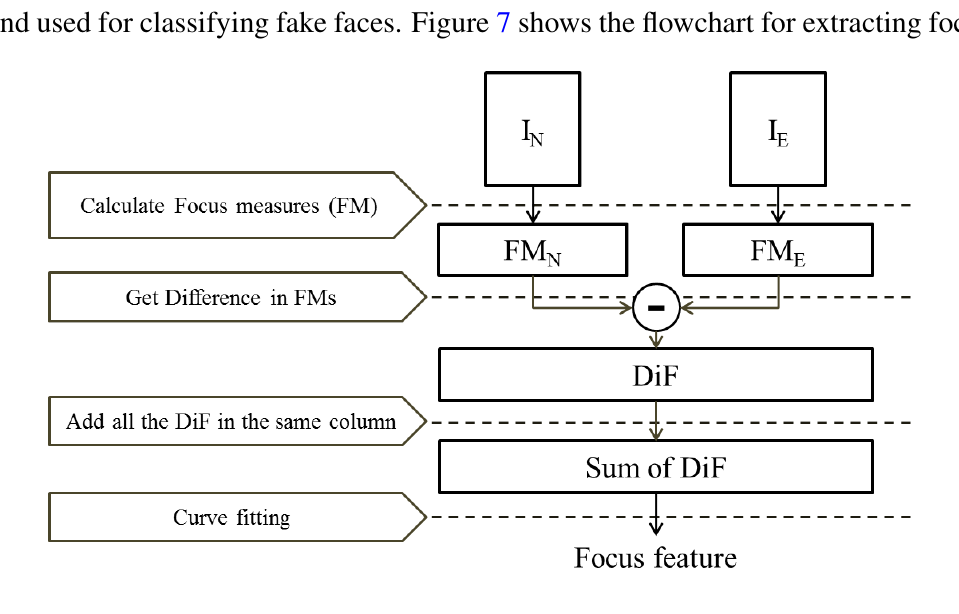
Figure 7. Flowchart of focus feature